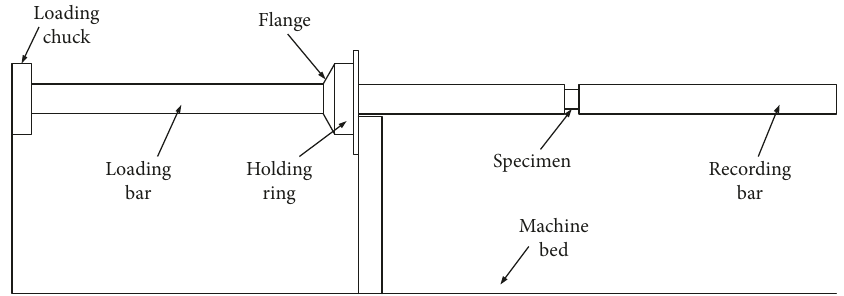
Figure 4: TSHB design by Lewis and Campbell [45].